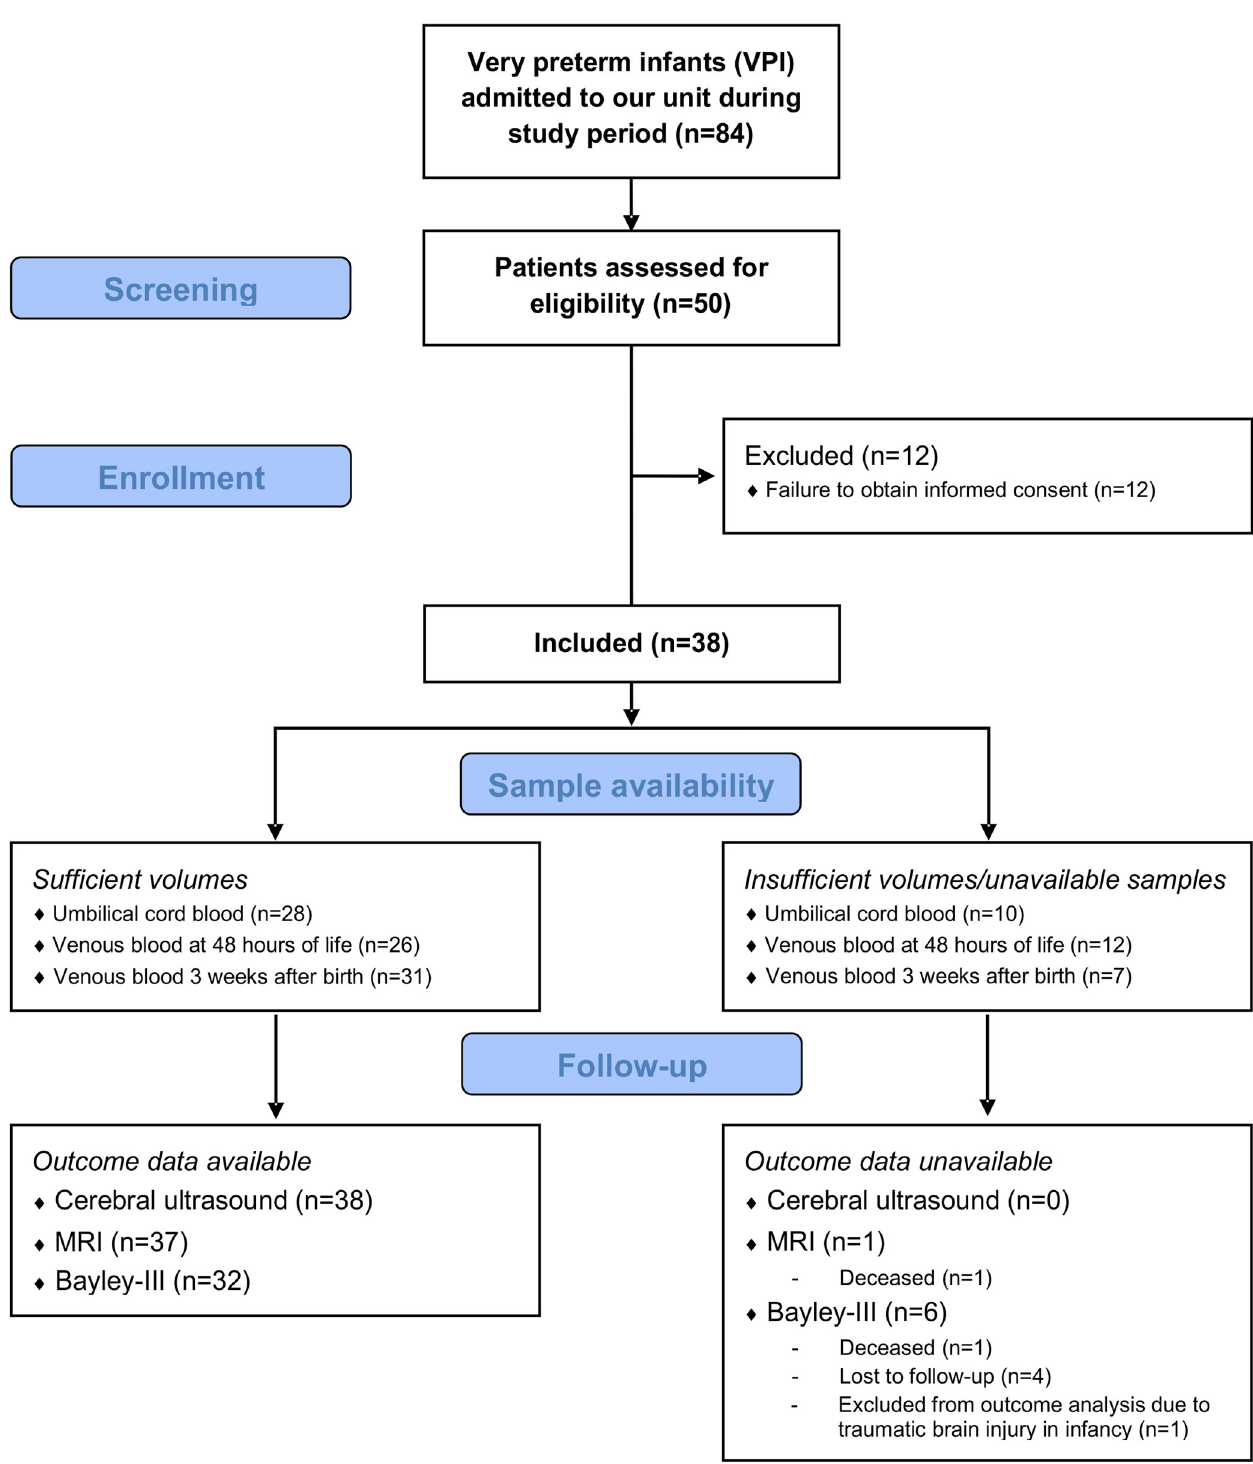
Fig 1. Flow diagram. Overview of all very preterm infants (VPI) admitted to our unit during the study period, patients assessed for eligibility and subjects enrolled in the study. Data availability with regard to secretoneurin measurements and outcome assessments is provided for all VPI included in the study. Data on basic perinatal characteristics were available for all included subjects. VPI , very preterm infants.